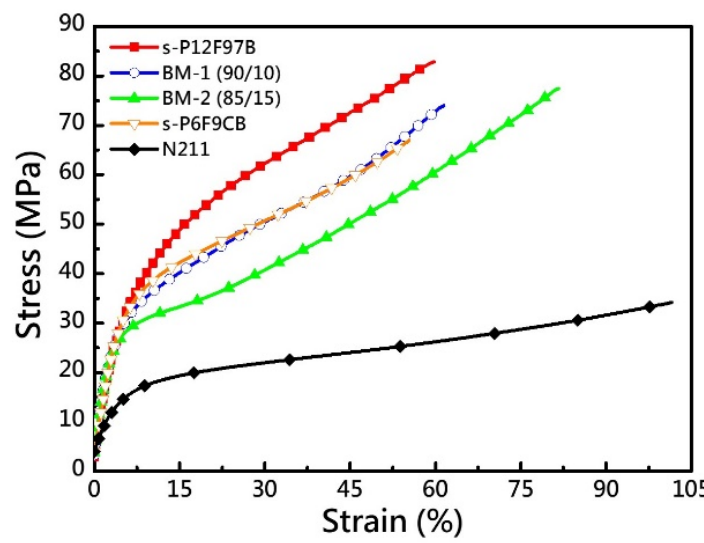
Figure 4. Stress–strain curves of membranes at 25 °C and RH of 40%.